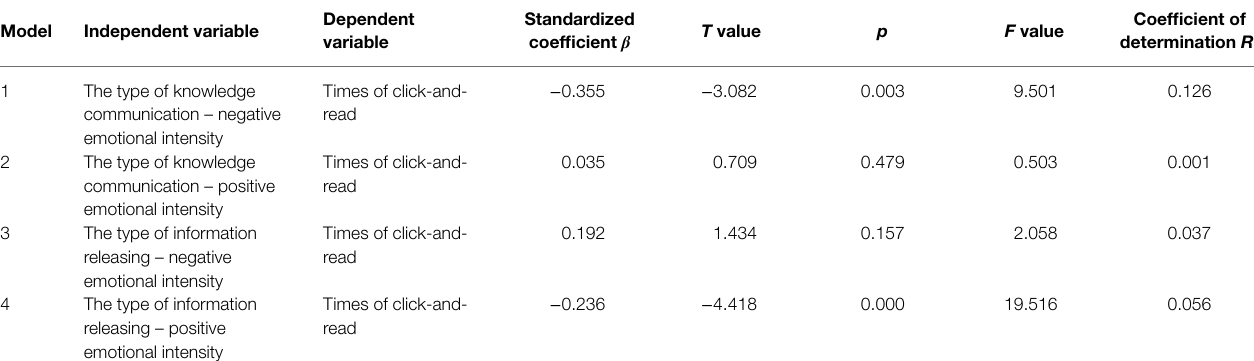
TABLE 5 | Regression analysis results of the impact of emotional intensity and emotional polarity of the tweet title on audience’s click-and-read behavior.